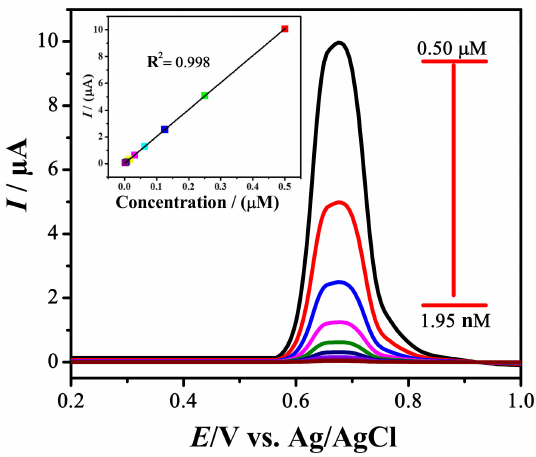
Figure 10. SWAS voltammograms of VEN in the concentration range of 0.5 µ M to 1.95 nM at Co–Pd@Al 2 O 3 /GCE in a BRB solution with a pH of 7 under optimized conditions (scan rate of 50 mV/s, accumulation potential of − 0.5 V, and accumulation time of 60 s) and (graph in the inset) the plot of I pa versus the concentration of